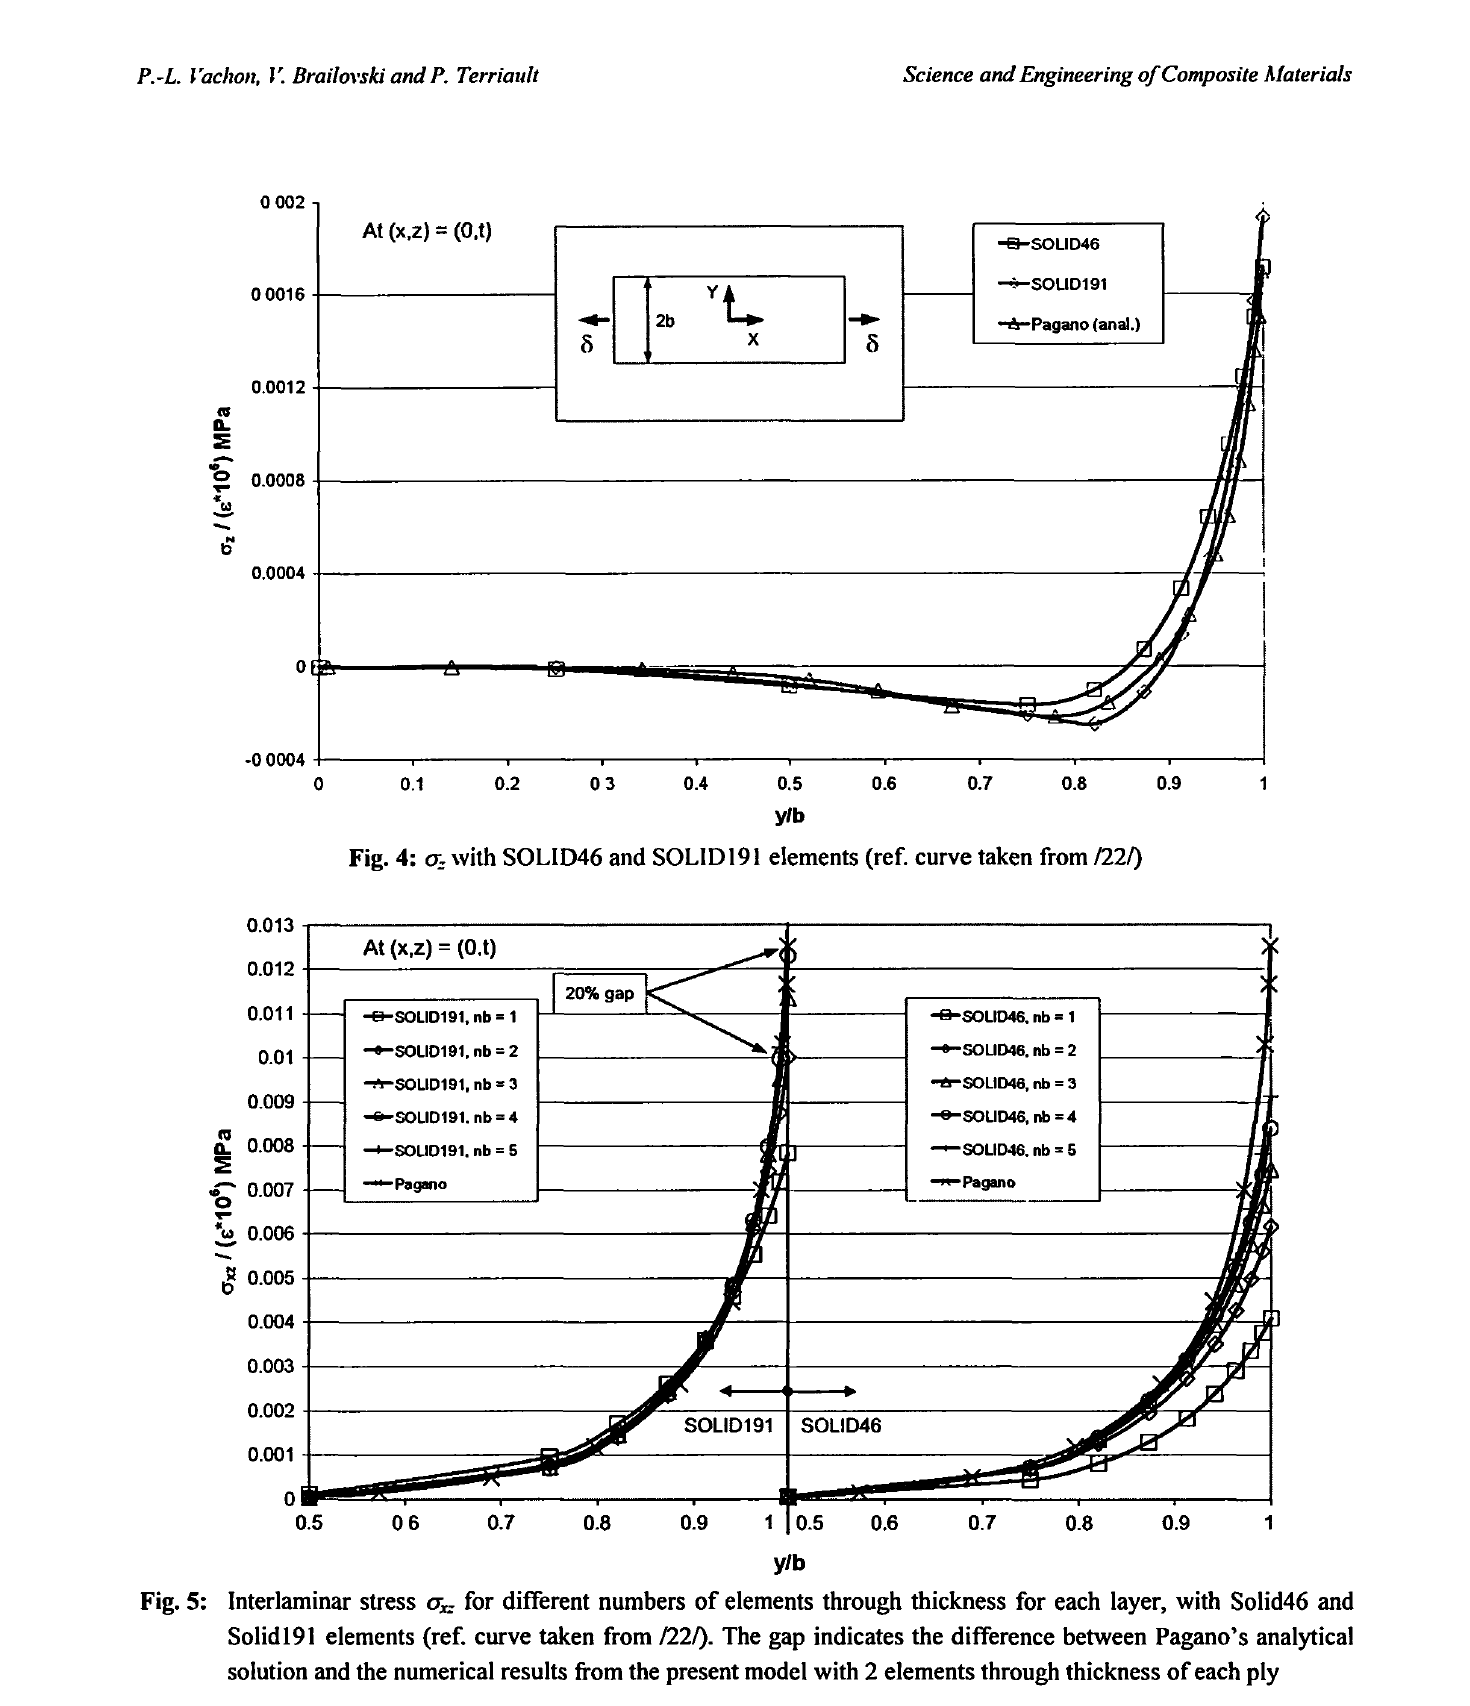
Fig. 5: Interlaminar stress σ for different numbers of elements through thickness for each layer, with Solid46 and χ: Solidl91 elements (ref. curve taken from /22/). The gap indicates the difference between Pagano's analytical solution and the numerical results from the present model with 2 elements through thickness of each ply